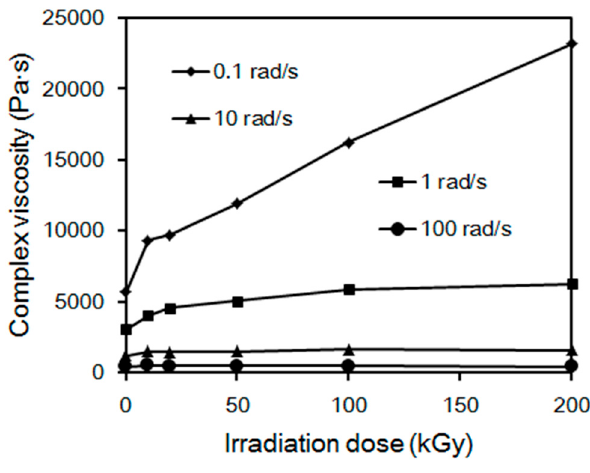
Figure 4. Complex viscosities of PA6/PP (80/20) blends as a function of irradiation dose at different frequencies.